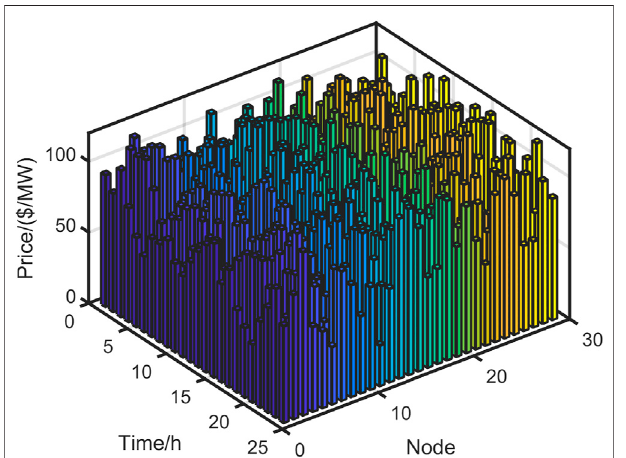
FIGURE 5 | The distribution of LMP in scenario 1.